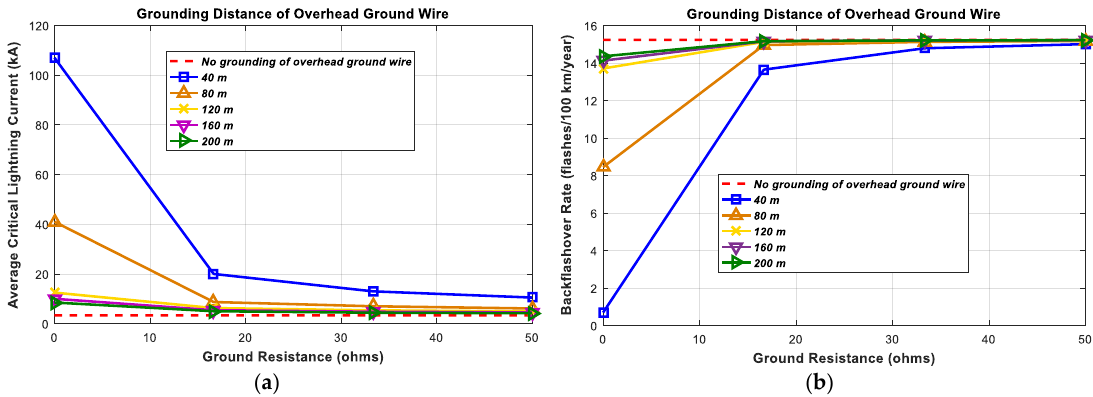
Figure 23. Critical lightning current and the back-flashover rate (lightning current waveform = 4.12/77.5 μs); ( a ) Critical lightning current; ( b ) Back-flashover rate.